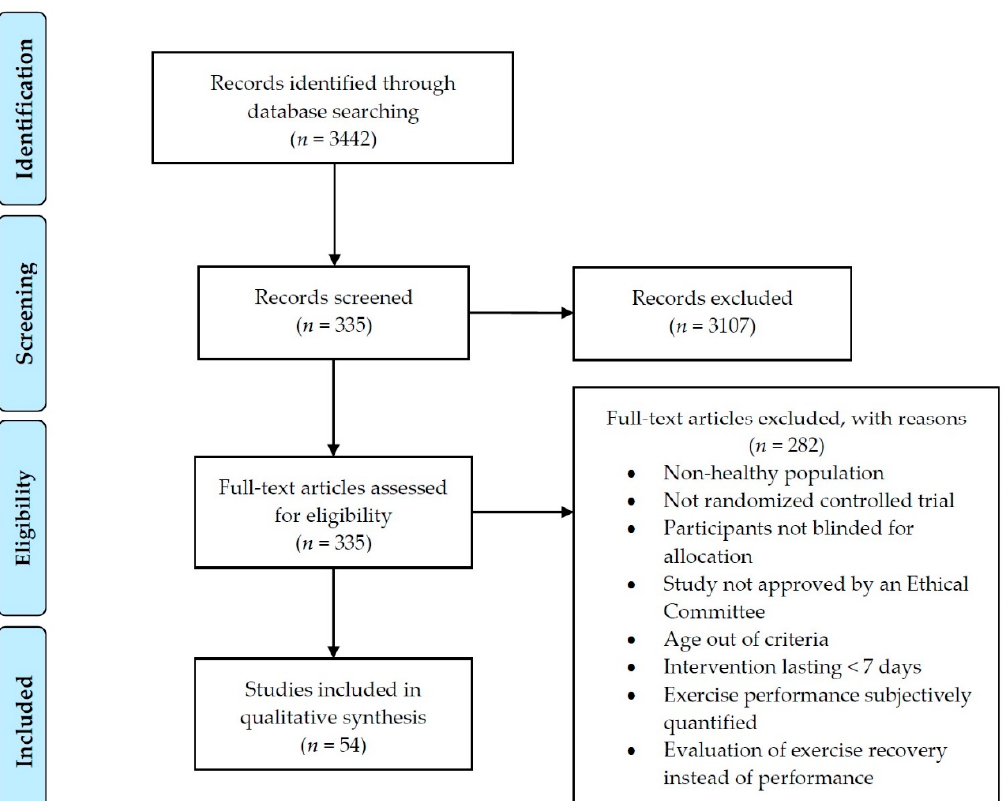
Figure 2. Flow diagram of the article selection process.